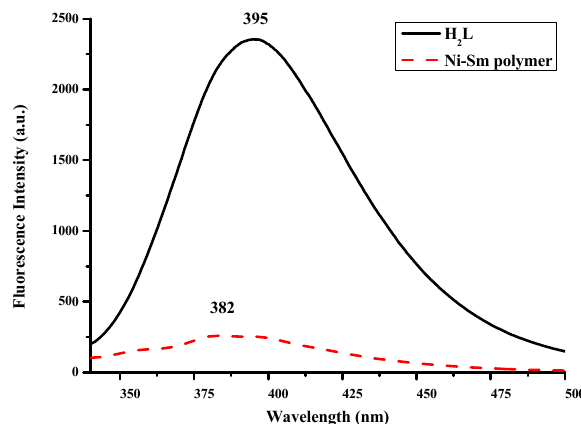
Figure 11. Photophysical properties of H 2 L and its corresponding Ni(II)-Sm(III) polymer in ethanol (1 × 10 − 5 mol L − 1 ) at 311 nm excitation.